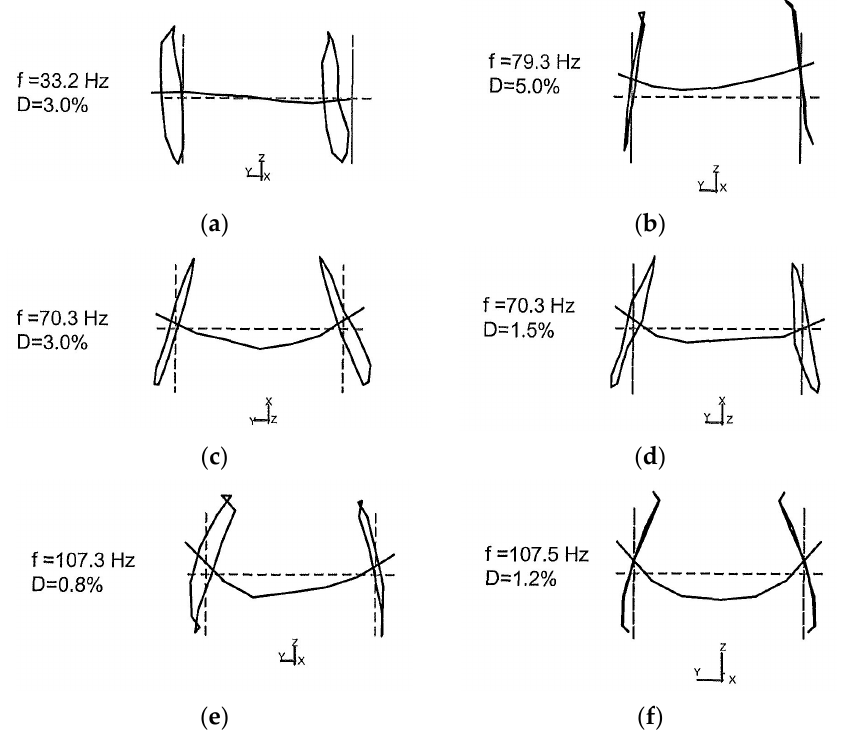
Figure 11. Measured modes of the wheelset [42], horizontal hammer impact on the wheel (left) ver- tical hammer impact on the mid-axle, ( a ) horizontal at 32.3 Hz, ( b ) vertical (with out-of-phase bending) at 79.3 Hz, ( c , d ) horizontal (free) bending at 70.3 Hz, ( e , f ) vertical (restrained) bending at 107.5 Hz.